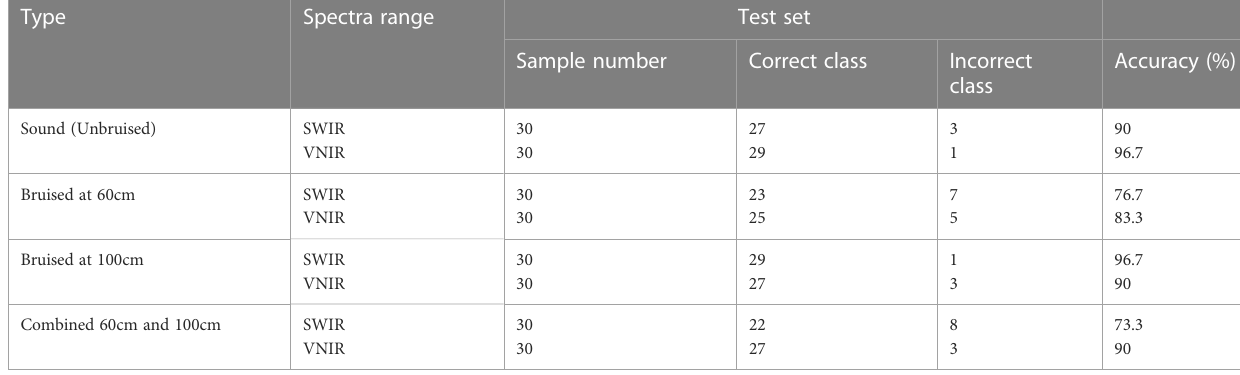
TABLE 2 Summary of results for the different bruise severity of pomegranate fruit.